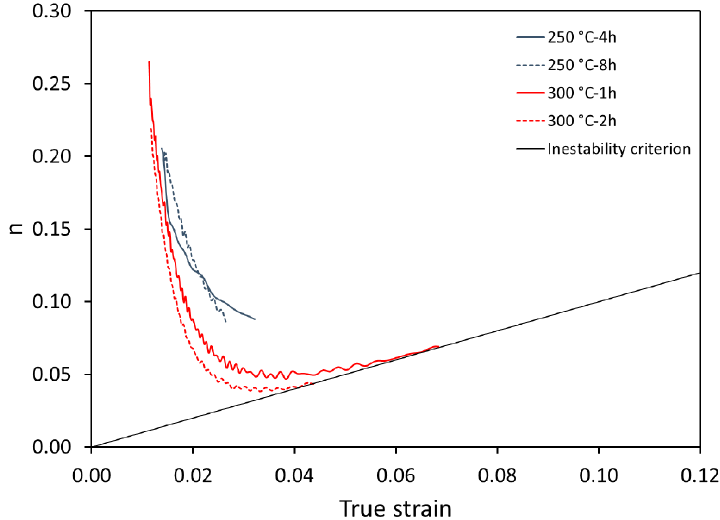
Figure 7. Incremental work hardening exponent, n , vs. true strain.